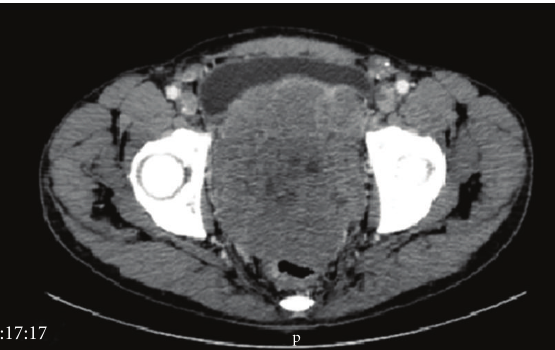
Figure 1: Pelvis CT showing a large pelvic mass.